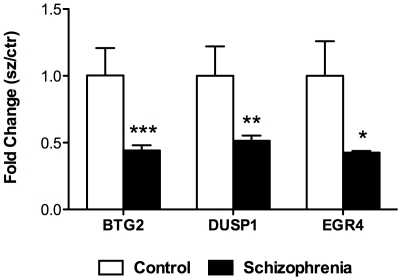
Quantitative real-time PCR validation of genes altered in schizophrenia.In an extended cohort of n = 28 schizophrenia subjects and n = 28 non-psychiatric controls, BTG2, DUSP1 and EGR4, each displayed significantly reduced expression in the schizophrenia group (black) by qPCR, confirming the changes observed by mRNA sequencing. BTG2 was down-regulated −2.27 fold (p = 0.00014), DUSP1 was down-regulated −1.94 fold (p = 0.004), and EGR4 was down-regulated −2.35 fold (p = 0.032). Statistics were performed using the Student's t-test (one-tailed). BTG2 and DUSP1 expression levels did not correlate with demographic variables age, PMI and pH. EGR4 significantly correlated with age (Spearman's rho = −0.454, p = 0.001) though remained within the threshold for significance when age was covaried for using ANCOVA. Bars are mean +SEM. * p<0.05; ** p<0.01; *** p<0.001.